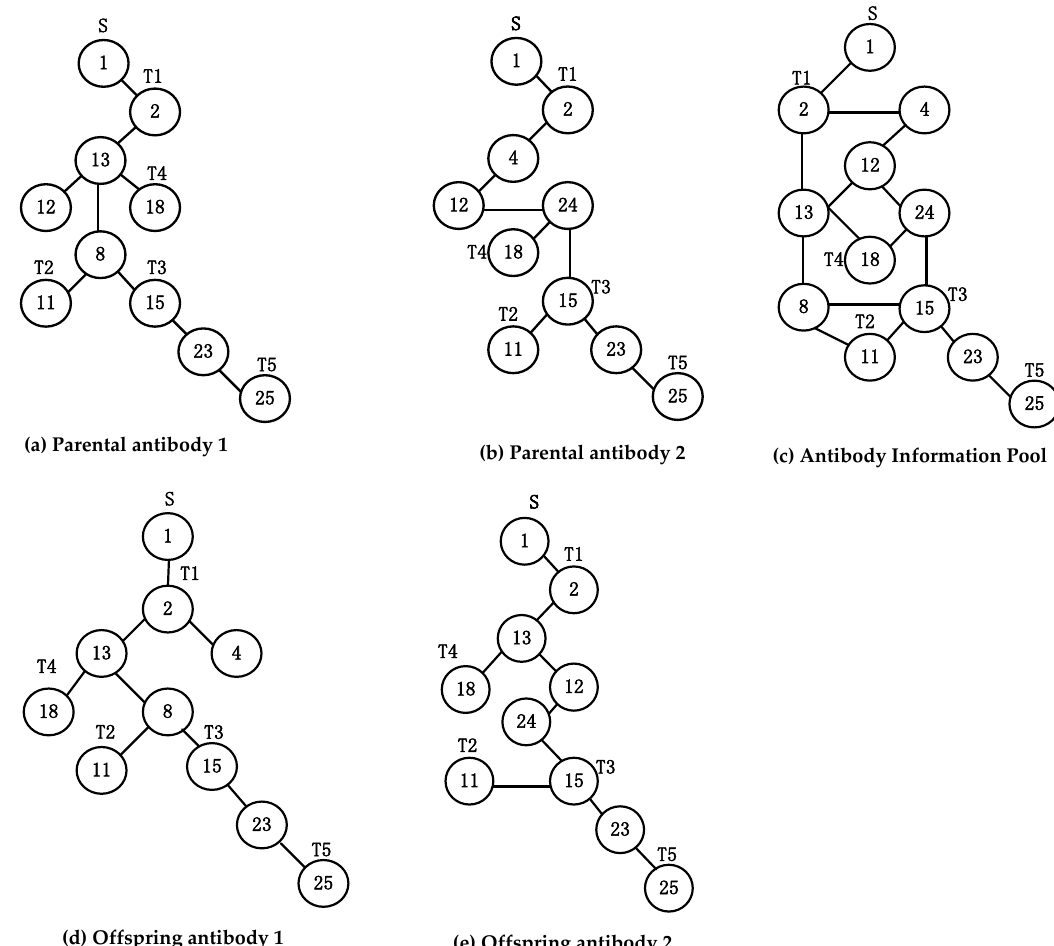
Figure 5. The process of crossover by parental